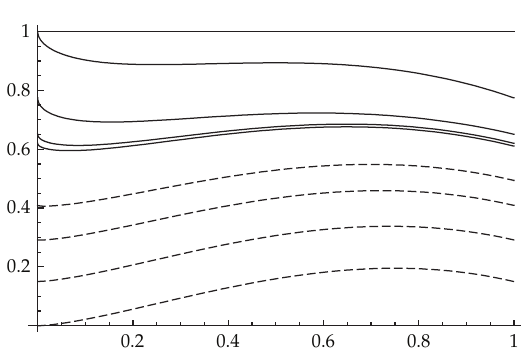
Figure 3: w 4 (cid:6) 0 (cid:7) ≈ 0 . 619877 and w 4 (cid:6) 1 (cid:7) ≈ 0 .